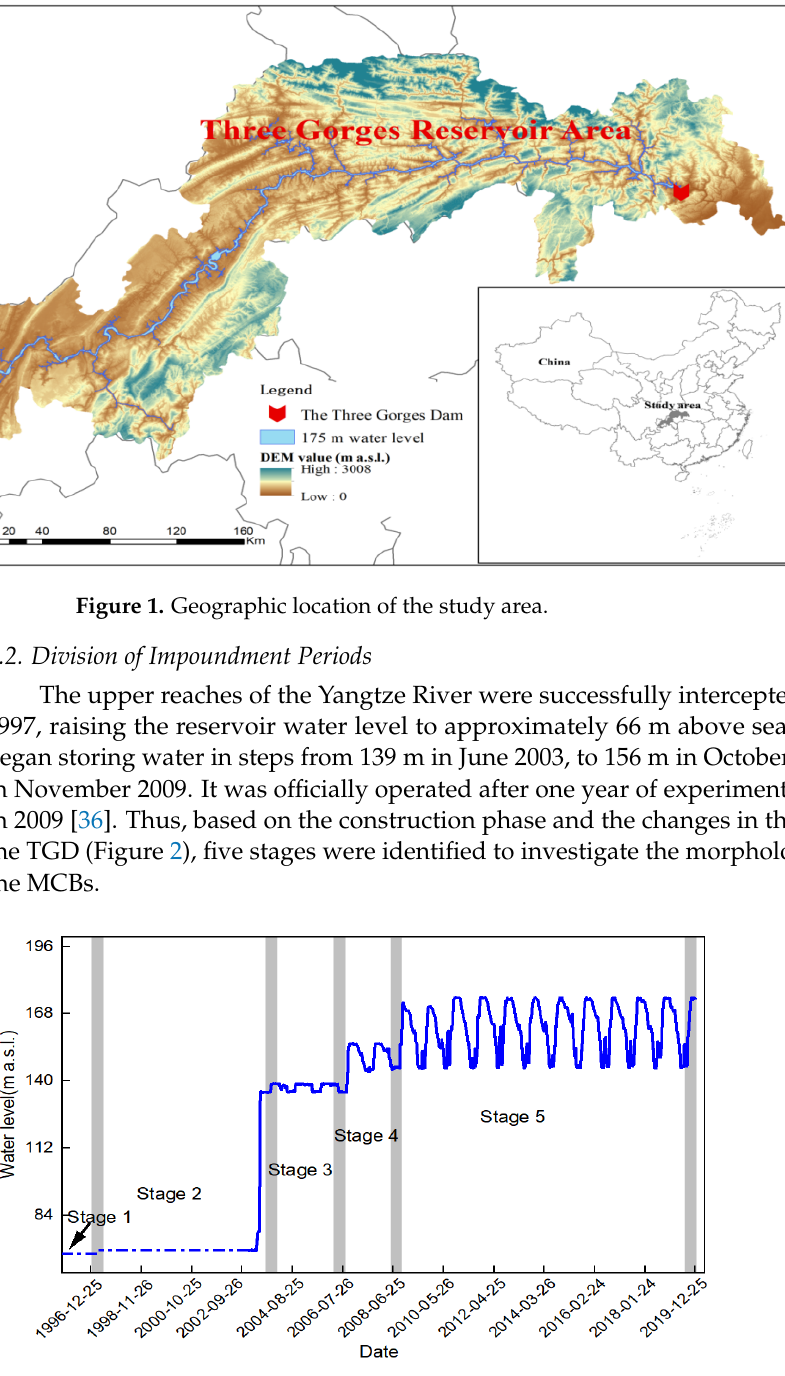
Figure 2. The water-level changes of TGR and division of impoundment